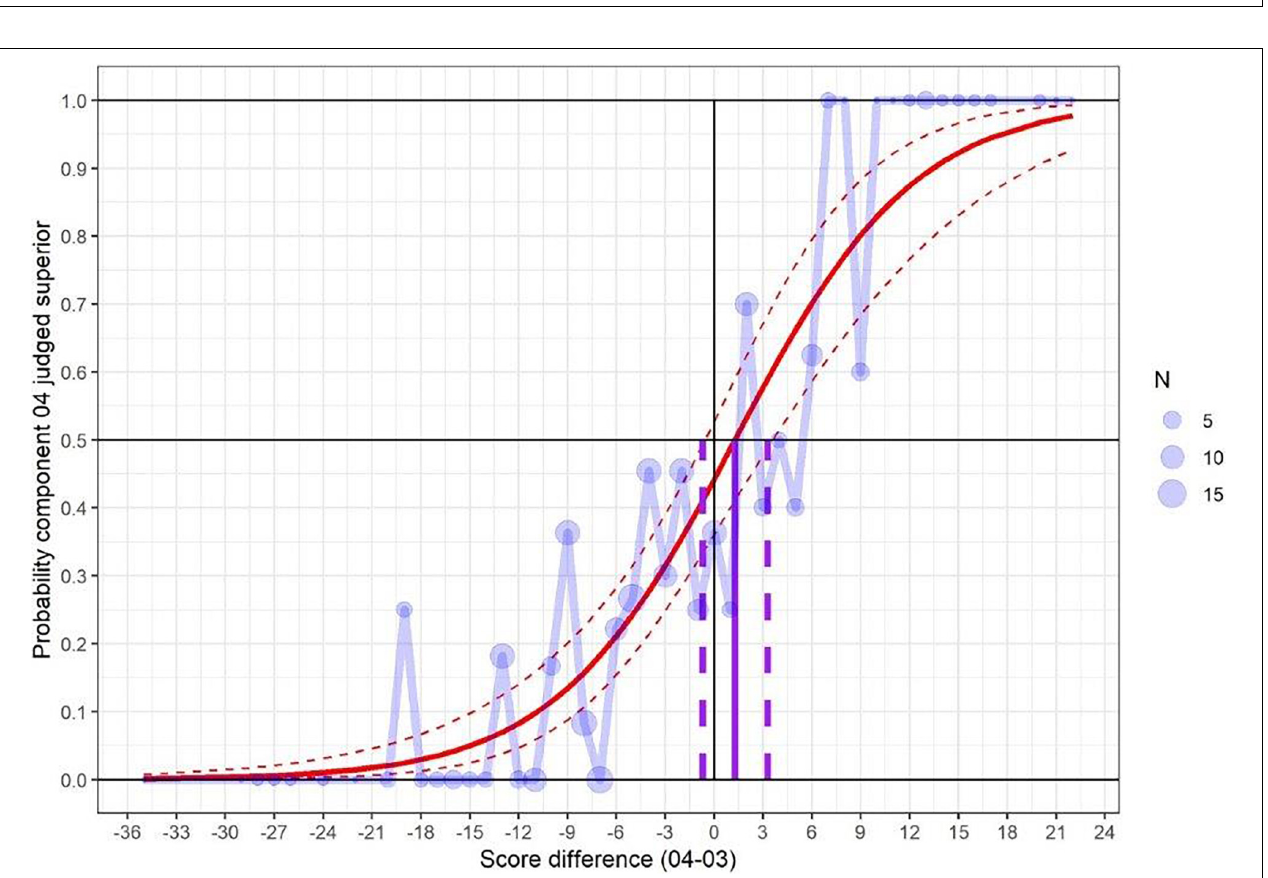
FIGURE 3 | Graphical depiction of the results of using simplified pairs to gauge the relative difficulty of two assessment versions (science).